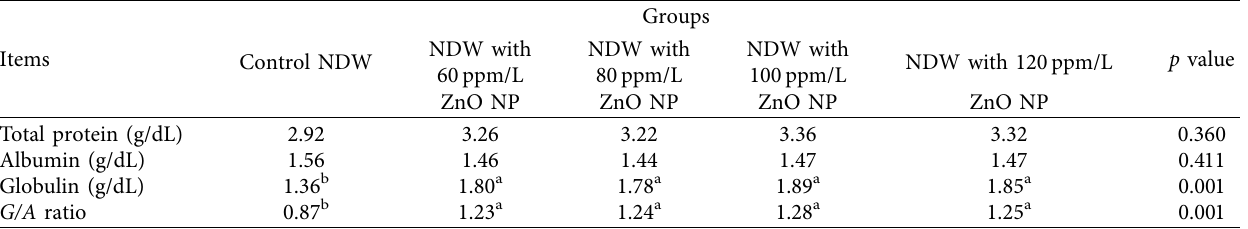
Table 4: Efect of zinc oxide nanoparticles (ZnO NPs) on total protein, albumin, globulin, and globulin to albumin ratio (%) at 42 days of